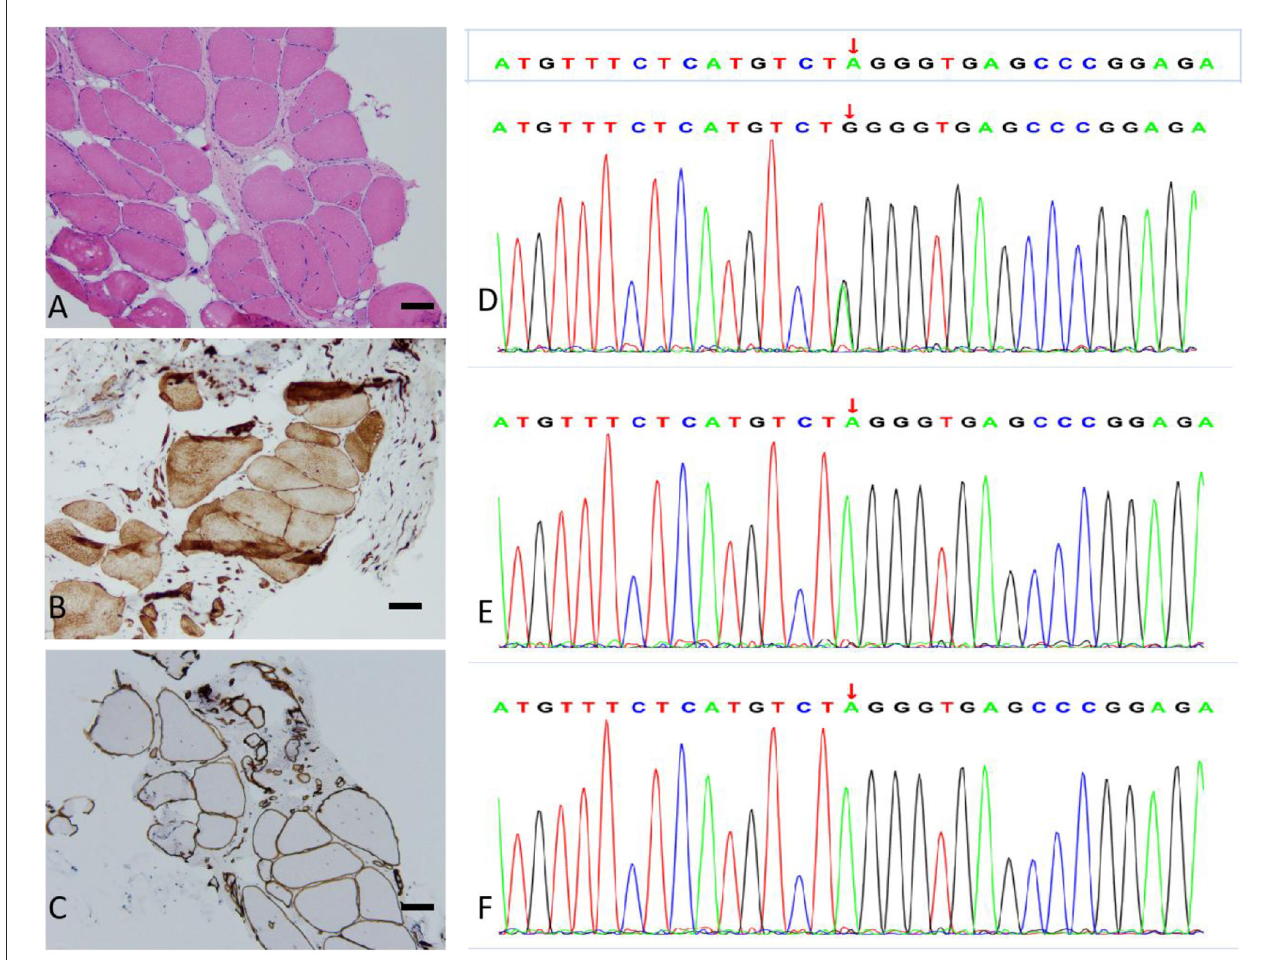
FIGURE2 Muscle biopsy (bar = 100 µ m) and genotype results. (A) Hematoxylin and eosin (H&E) staining: the skeletal muscle tissue of the right anterior tibial muscle exhibited a slight myogenic damage. (B) Dysferlin staining: the myofiber membrane and cytoplasm were positive. (C) α -Sarcoglycan staining: the muscle fiber membrane was positive, with a uniform and continuous expression. (D–F) Sequencing of the COL6A3 gene in the patient (D) , patient’s mother (E) , and patient’s son (F) . The variation c.6817-2(IVS27)A > G is present only in the